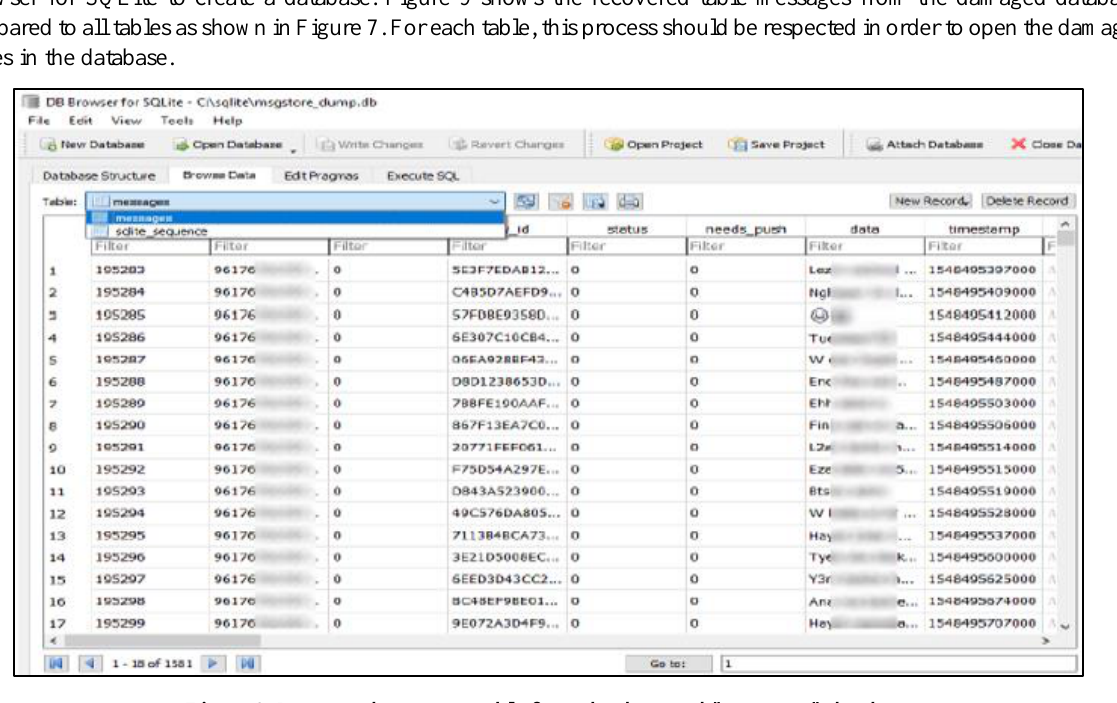
Figure 9. Recovered messages table from the damaged "msgstore"